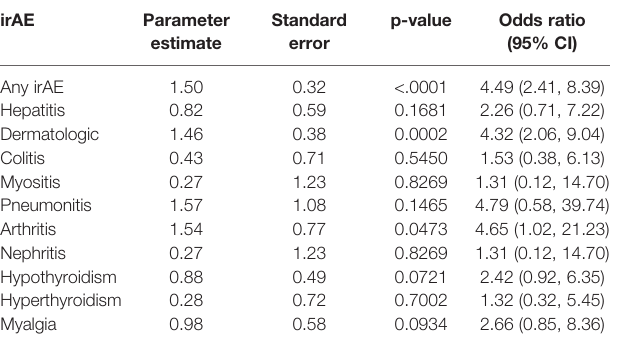
TABLE 3 | Univariate logistic regression analysis for the association of irAE with any response.